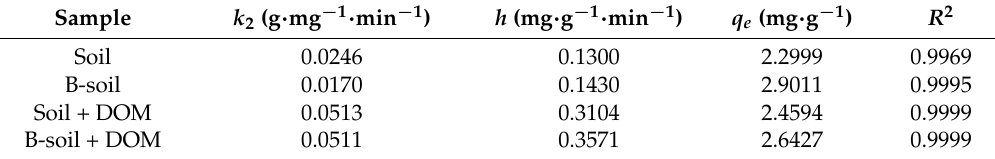
Figure 5. Relation between BPs adsorption amount and the contact time. Table 1. Fitting parameters of the pseudo-second-order kinetic model.